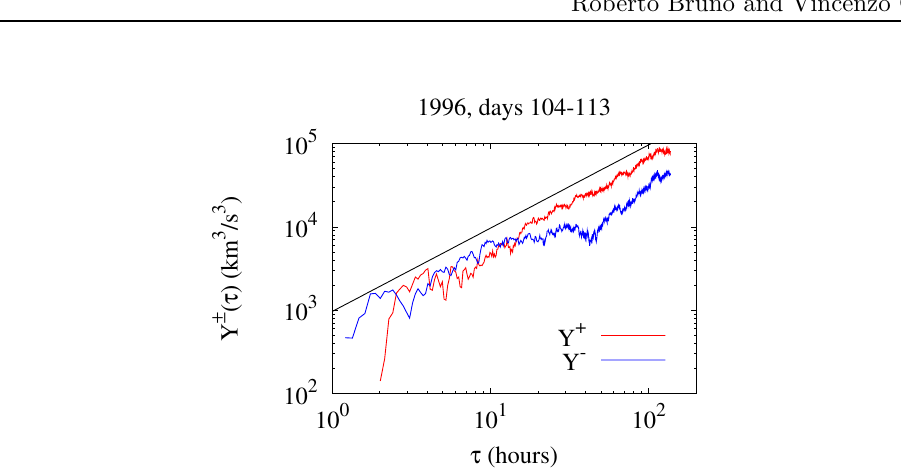
Figure 92: An example of the linear scaling for the third-order mixed structure functions 𝑌 ± , obtained in the polar wind using Ulysses measurements. A linear scaling law represents a range of scales where Yaglom’s law is satisfied. Image reproduced by permission from Sorriso-Valvo et al. (2007), copyright by